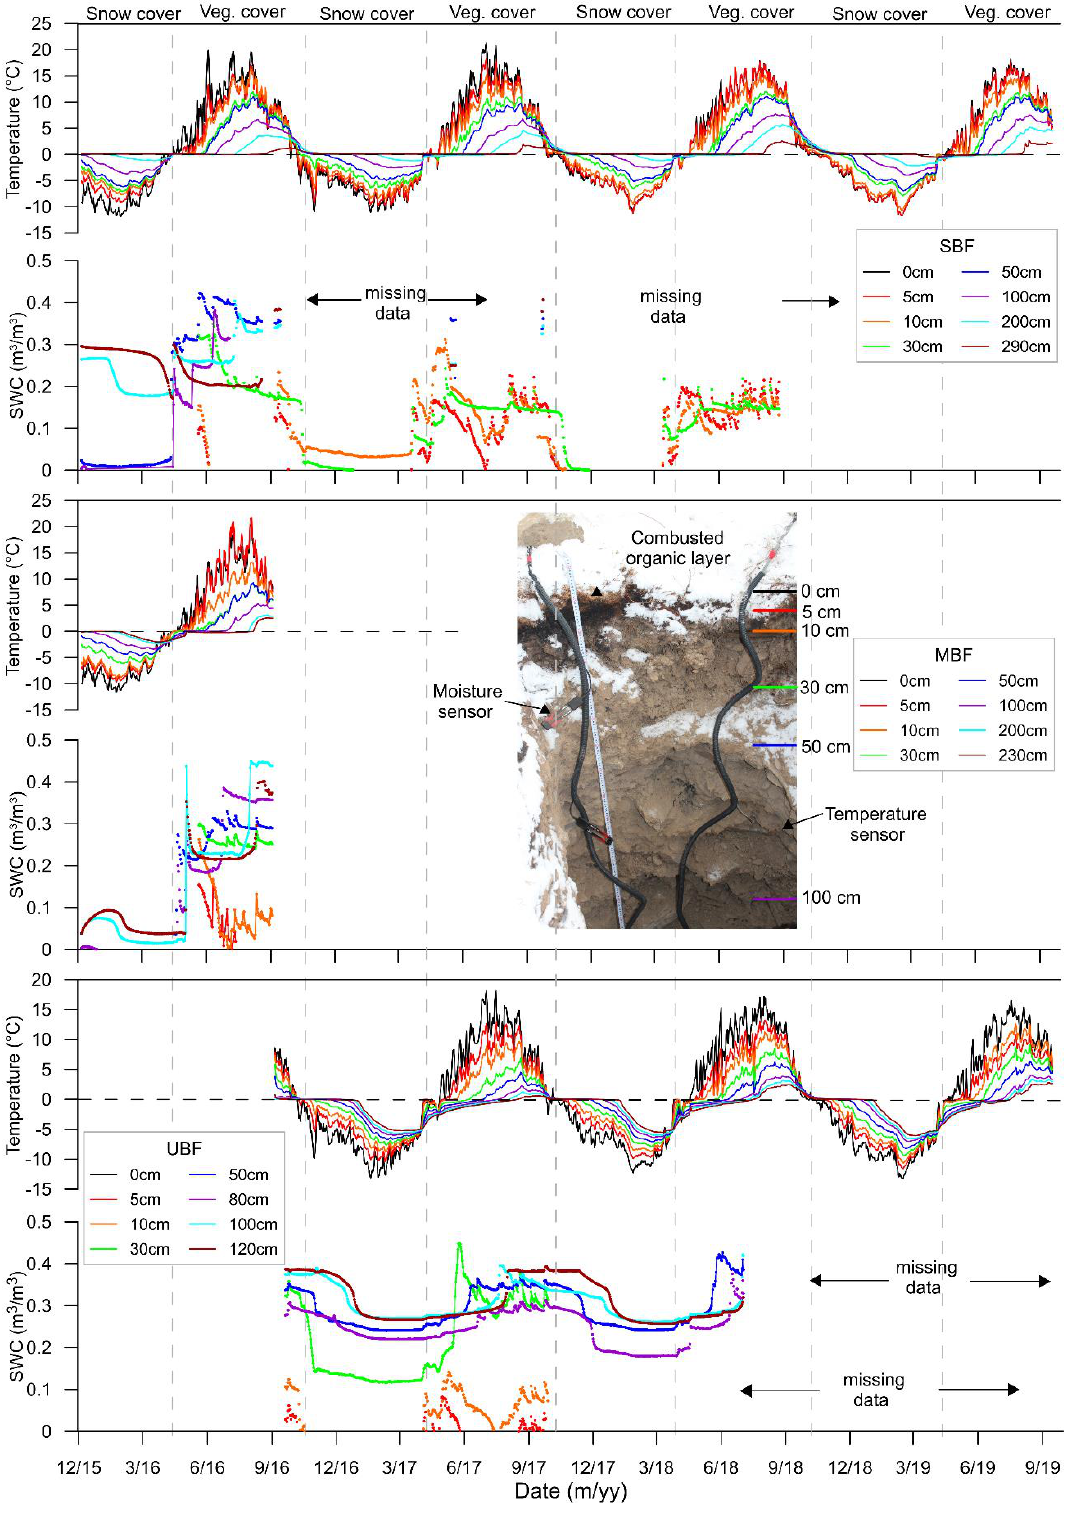
Figure 2. Observed soil temperature and water content (SWC) in the pits at severely burned (SBF), moderate burned (MBF), and unburned (UBF) forest sites. Moisture and temperature sensors were shifted from MBF to UBF in September 2016. The inset photograph from the MBF site illustrates the general positioning of the sensors and soil profile.